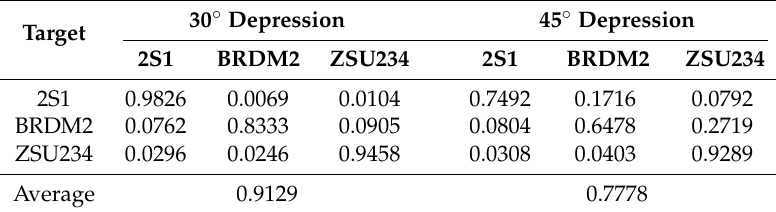
Figure 11. The recognition rates of various methods. The number on the right of the bar represents the decrease in recognition performance across the range of depression variation from 30 ◦ to 45 ◦ . Table 6. Recognition accuracies of MLA-LSR on the depression and articulation variation database.